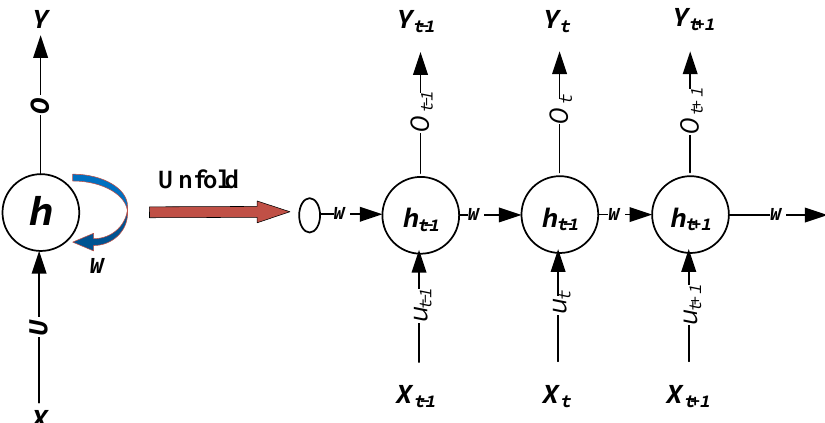
Figure 2. Workflow graph of RNN. X denotes current input of neural network; Y denotes the output of neural network; W , U and O are the parameters of recurrent neural network; h is the neuron state of the hidden layer; The state at time t is related to the current input X and the hidden at time t − 1.